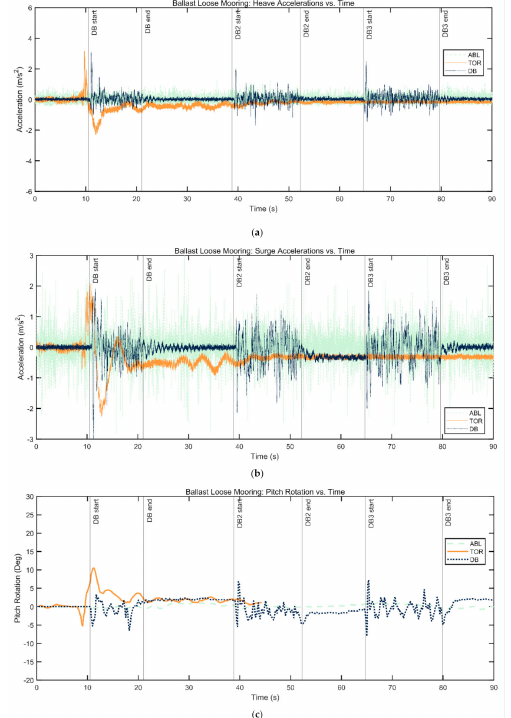
Figure 13. ( a ) Heave acceleration, ( b ) Surge acceleration, and ( c ) Pitch rotation of Configuration 3-Loosely moored ballasted